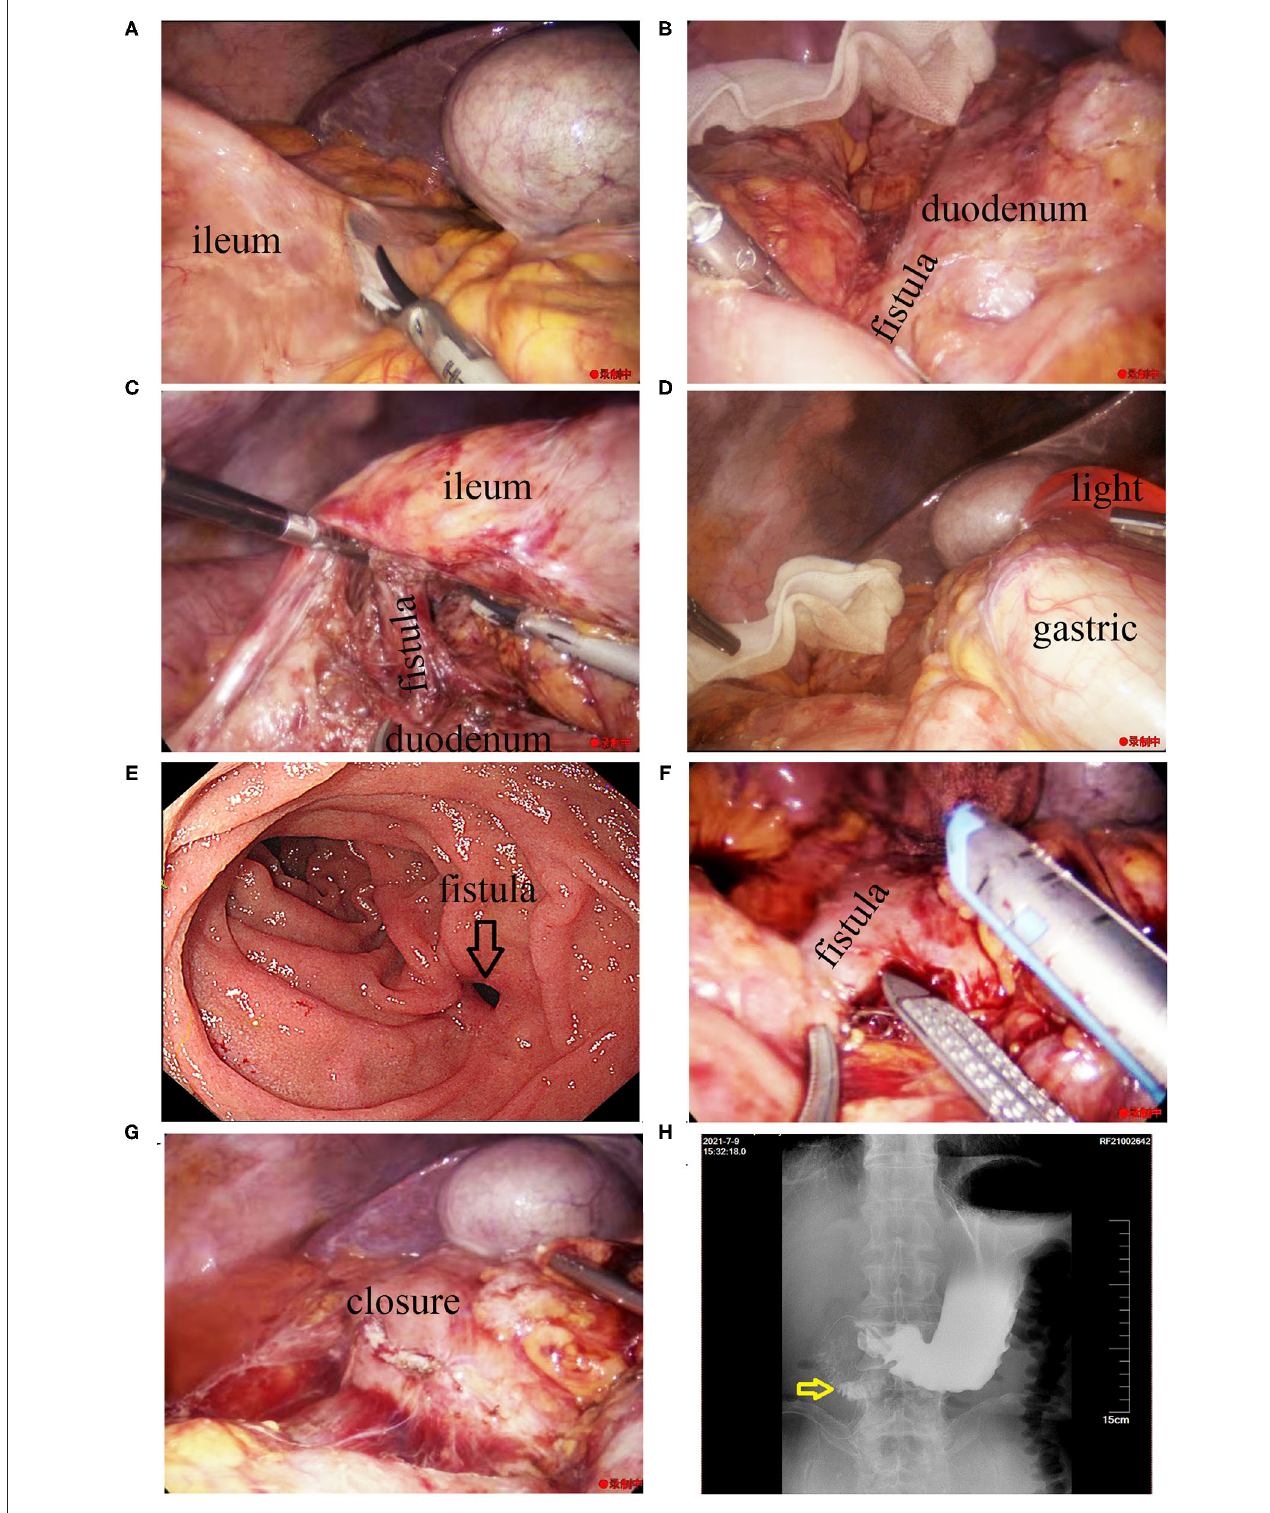
FIGURE 4 | Intraoperative imaging findings during laparoscopic treatment of the fistula. (A) The small intestine was observed to have adhered to the right upper abdomen. (B) A tubular structure was seen in the lateral part of the lower duodenum, connecting to the distal ileum. (C) The tubular structure can be seen from the